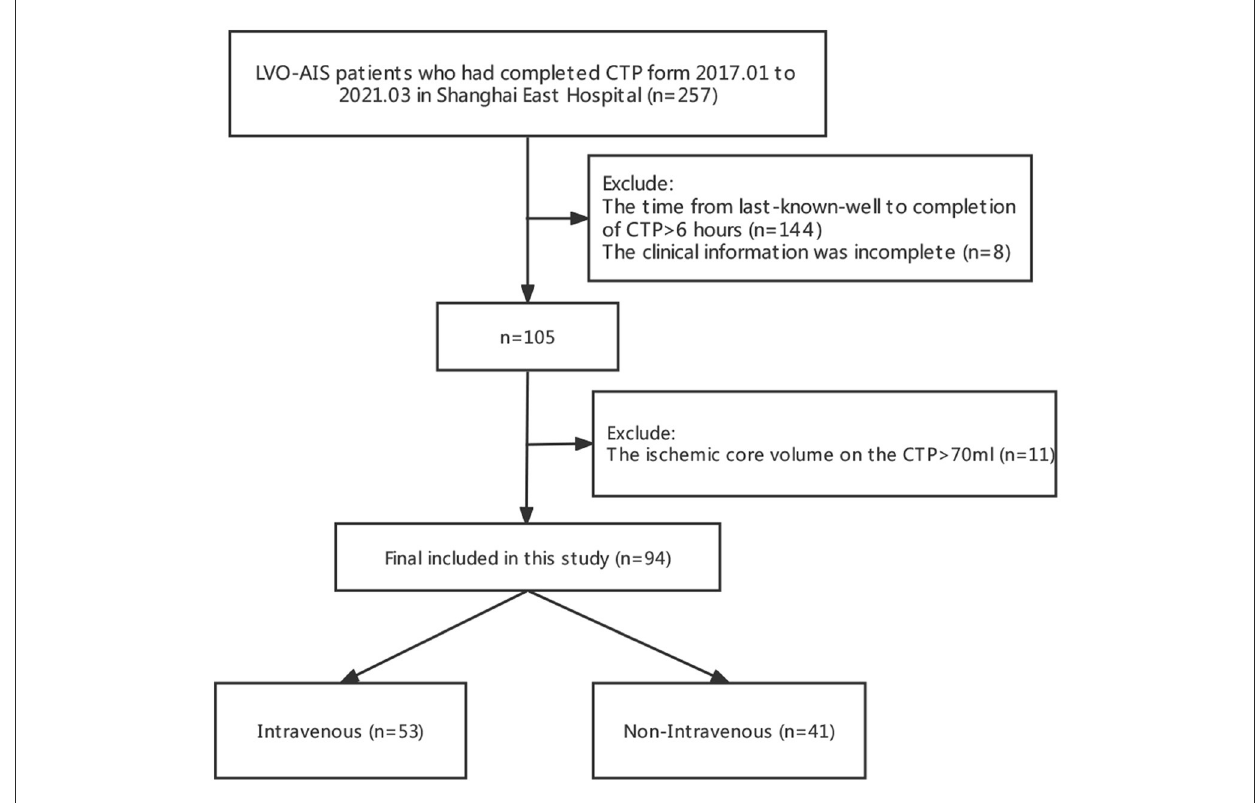
FIGURE1 A flow diagram of the study.